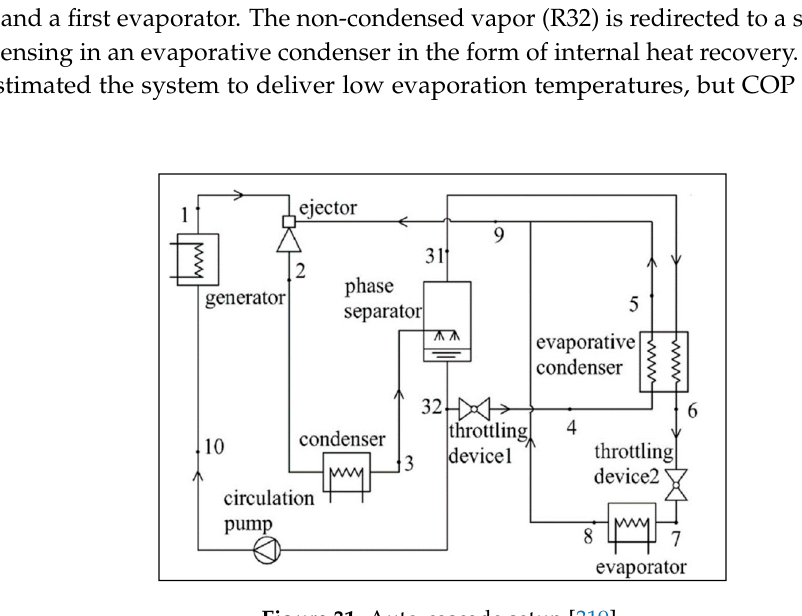
Figure 31. Auto-cascade setup [319].